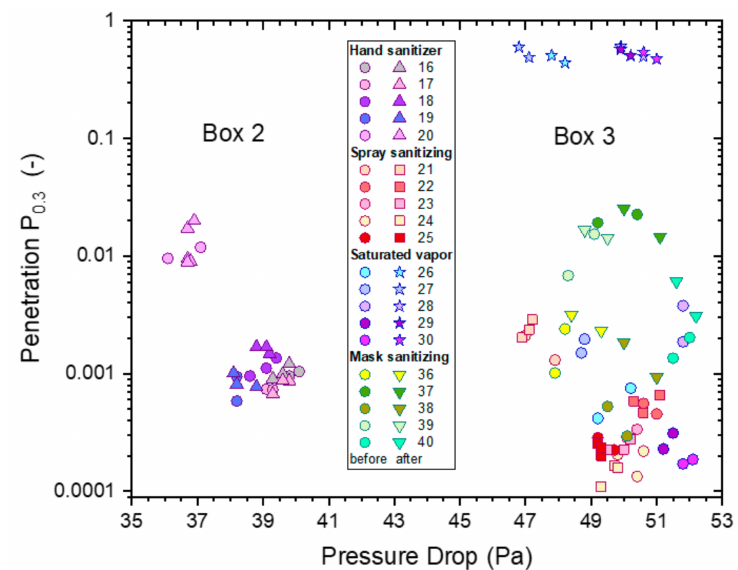
Figure 17. The penetrations from ‘whole-mask screening’ tests from treated and untreated mask samples for particles of 0.3–0.5 µ m diameter as a function of pressure drop for each sample before and after four different alcoholic exposure treatments: saturated vapor treatments (5 h, IPA, stars), hand sanitizer (4 h, EtOH, triangles), spray sanitizer (4 h, IPA, squares) and mask sanitization (3 spray pulls, IPA, inverted triangles). For comparison purposes, the results of samples before treatment (Figure 16) are also included, represented by circular symbols with the same coloring as the respective treated